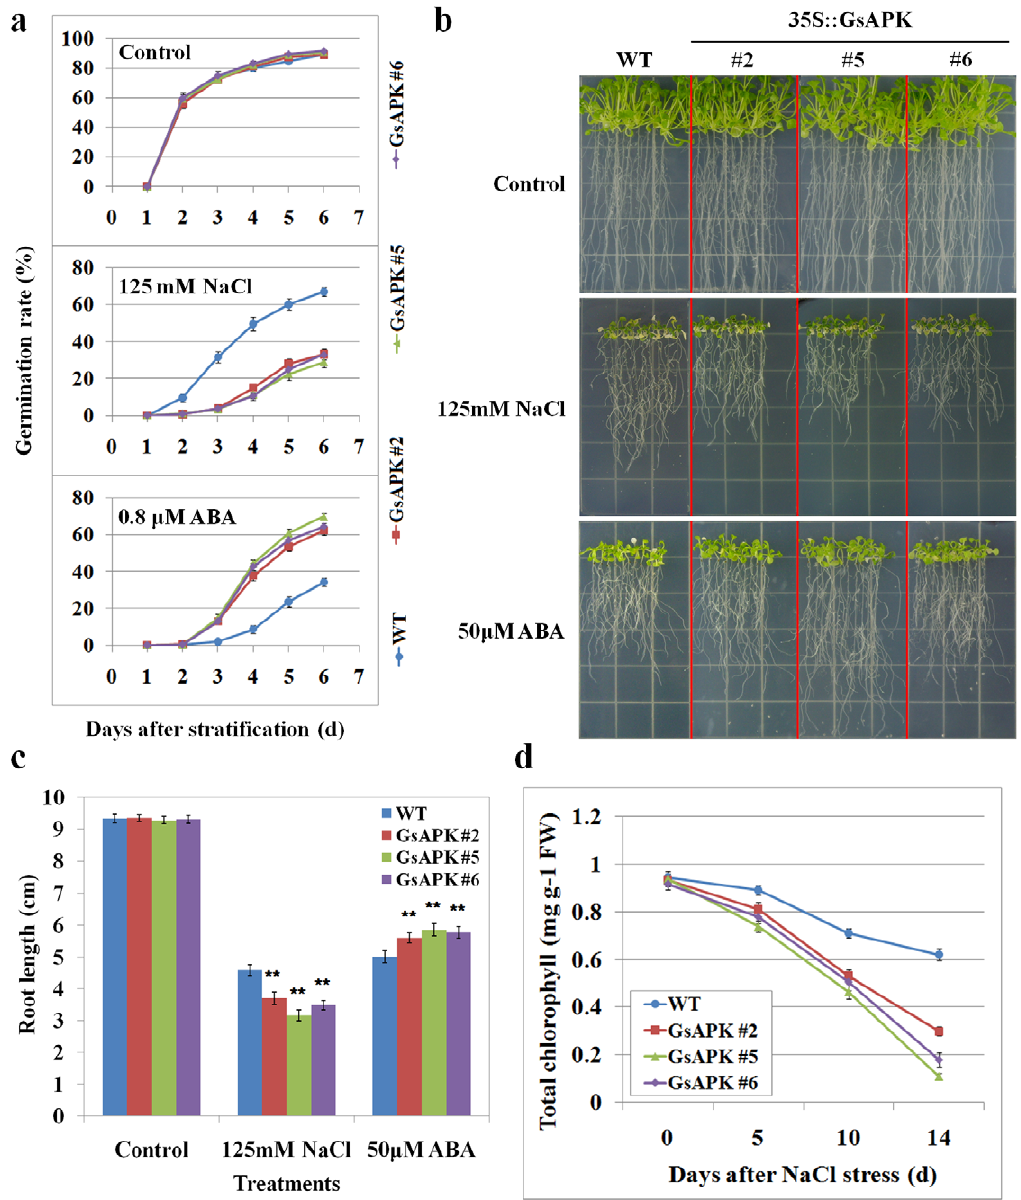
Figure 6. Phenotypic analysis of transgenic Arabidopsis plants under salinity stress and ABA treatments. a. Response of seed germination to ABA and NaCl in transgenic and wild-type Arabidopsis plants. Seeds from three transgenic and wild-type Arabidopsis were stratified on 0.5 6 MS agar plates in the absence or presence of 100 mM NaCl or 0.8 m M ABA, respectively. Data are means ( 6 S.E.) of five replicates (each with 100 seeds for each line). b. Phenotypes of wild-type and three transgenic seedlings grown in control or stress condition. 7-day-old WT and transgenic seedlings grown on 0.5 6 MS were transferred to new solid agar plates supplemented with 125 mM NaCl or 50 m M ABA, respectively. Photographs were taken after 12 days growth. c. Measurements of root lengths of plants shown in b. d. Time course total chlorophyll content of wild-type and three transgenic seedlings under NaCl stress. Three-week-old soil-grown plants were irrigated with 200 mM NaCl for 2 weeks and the total chlorophyll content among the wild-type and three transgenic plants were measured. All values in c and d are means ( 6 S.E.) from three independent experiments (30 seedlings per experiment). **: P , 0.01 by Student’s t test. doi:10.1371/journal.pone.0033838.g006 20 u C and purified over ProBond TM Nickel-Chelating Resin as instructed by the ProBond Purification System manufacturer. Two-week-old transgenic Arabidopsis roots treated for 3 h with Subcellular localization of GsAPK protein 10 m M ABA, then three-gram-plant tissue was collected and ground in 4 volumes/g fresh weight of extraction buffer (50 mM For the analysis of the subcellular localization of GsAPK protein phosphate, pH 8.0, 10 mM Tris, pH 8.0, 500 mM NaCl, 0.1% using the fluorescent protein reporter gene, the GsAPK gene coding sequence was amplified with primer pair (5 9 -CCATGGAGATG- Tween 20, 0.1% Nonidet P-40, 0.1% b -mercaptoethanol, 1 mM